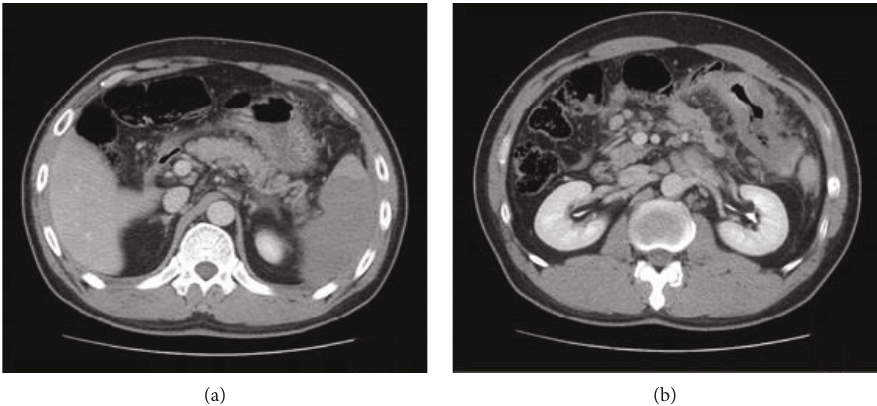
Figure 1: CT scan of patient no. 5. (a) Axial section of the CT scan showed an infarction of the lower pole of the spleen on admission. (b) Axial section of the CT scan showed a colon tumor of the splenic fl exure.